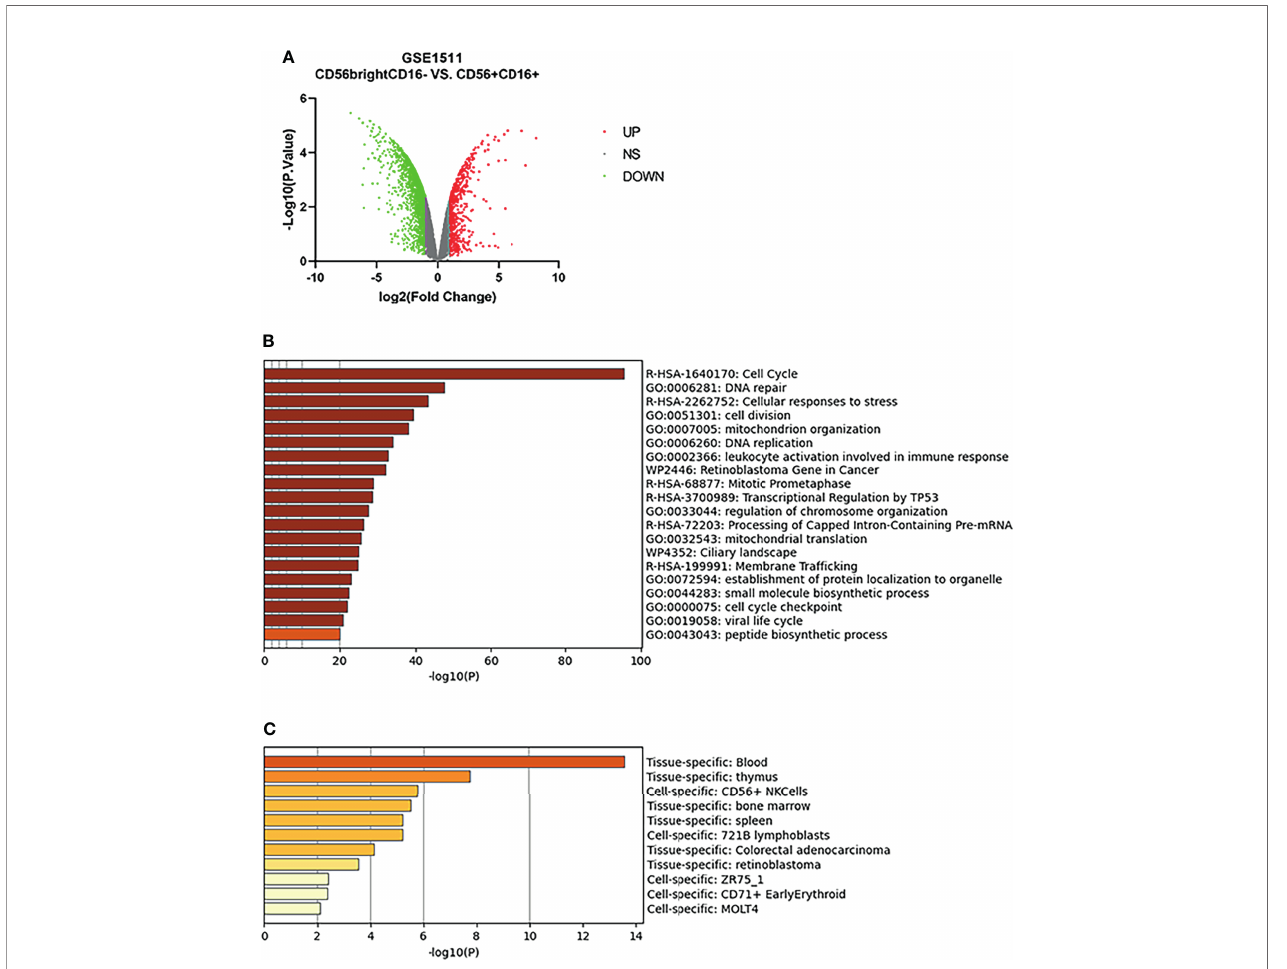
FIGURE 4 | Differentially expressed genes in activated CD56 + CD16 + human NK cell subset samples. (A) Volcano plot for differentially expressing genes between CD56 bright CD16 - and activated CD56 + CD16 + human NK cell subset samples. Red dots represented signi fi cantly upregulated genes, while green dots represented signi fi cantly downregulated genes. (B) Heatmap of Gene Ontology (GO) and Kyoto Encyclopedia of Genes and Genomes (KEGG) enriched clusters colored by p -value. (C) The summary of enrichment analysis in PaGenBase con fi rmed tissue and cell speci fi c for these genes.